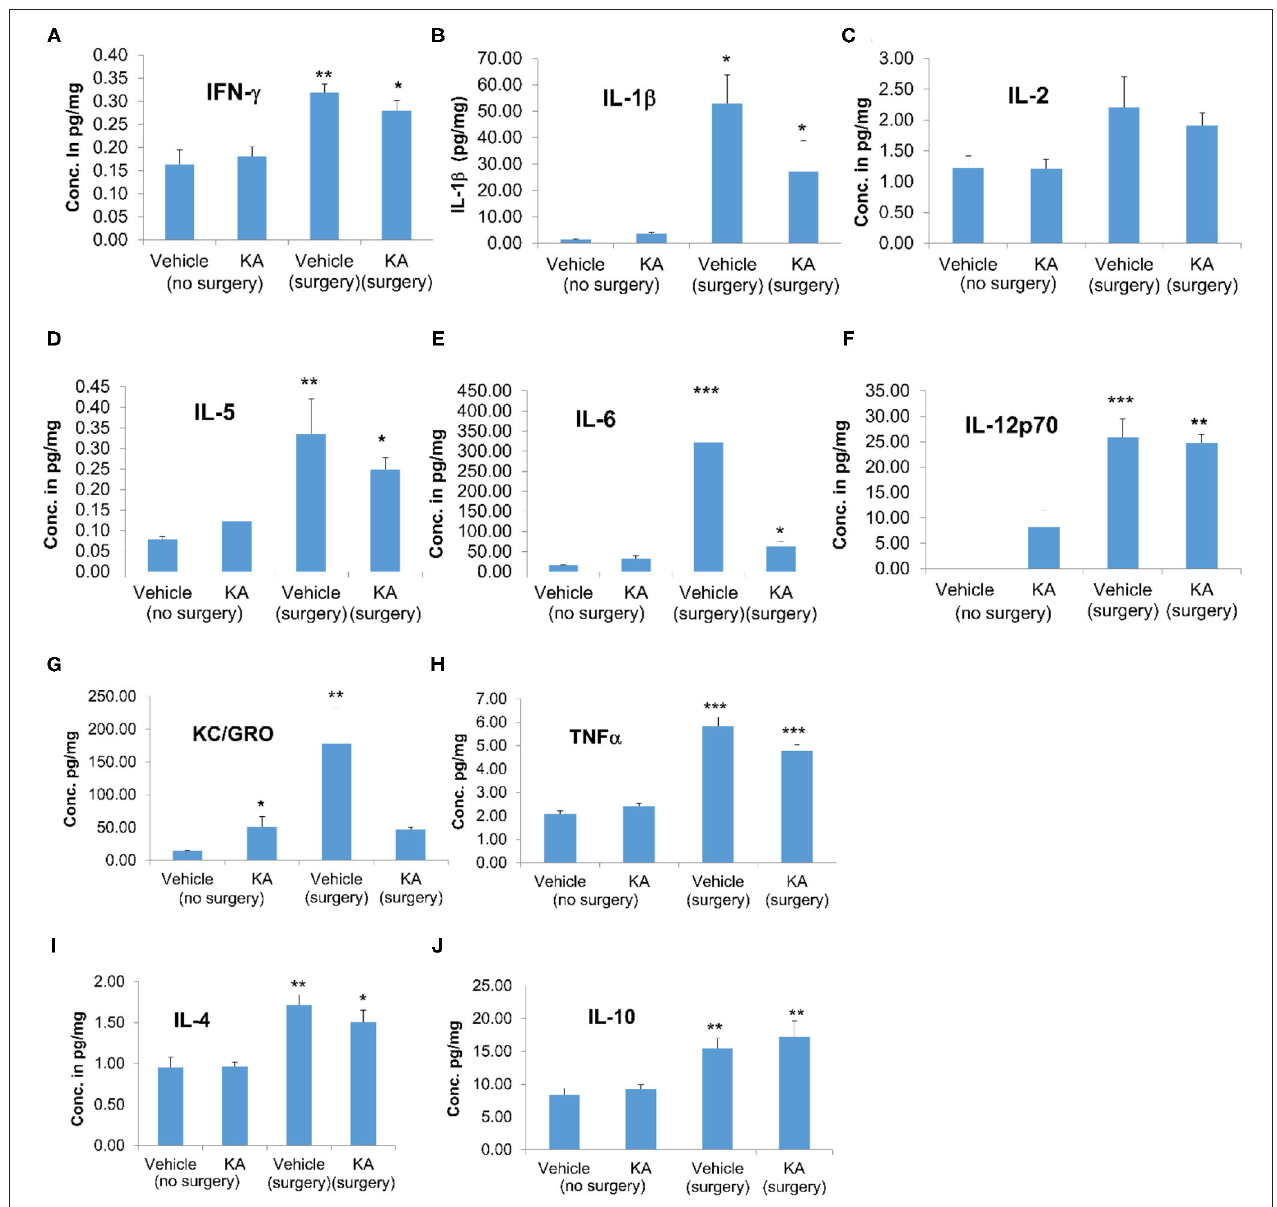
FIGURE 5 | The effects of the vehicle or KA treatment in mice that had surgery for implantation of intracerebral electrodes or without surgery on inflammatory cytokines in the cerebral cortex. The following cytokines were measured and represented in the graphs: (A) interferon- γ (IFN- γ ), (B) interleukin-1 β (IL-1 β ), (C) interleukin-2 (IL-2), (D) interleukin-5 (IL-5), (E) interleukin-6 (IL-6), (F) interleukin-12p70 (IL-12p70), (G) keratinocyte-derived cytokine/growth-related oncogene (KC-GRO), (H) tumor necrosis factor- α (TNF- α ), (I) interleukin-4 (IL-4), (J) interleukin-10 (IL-10). The data are expressed as the mean ( ± SEM) cytokine concentration in pg/mg protein. The values were compared across all four groups using one-way ANOVA with Tukey’s post-hoc test ( n = 4, * p < 0.05; ** p < 0.01; *** p < 0.001).